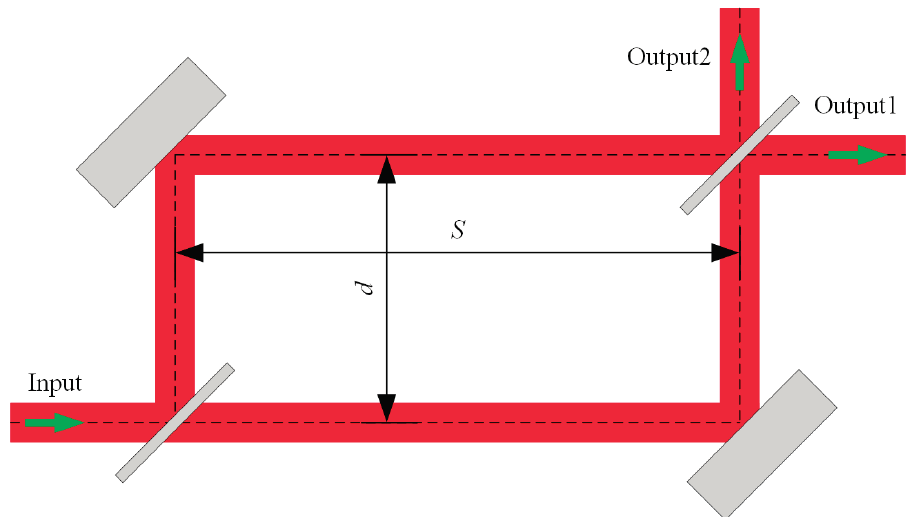
Figure 13. Schematic of the MZI using media trenches based on SOI rib waveguide with large cross